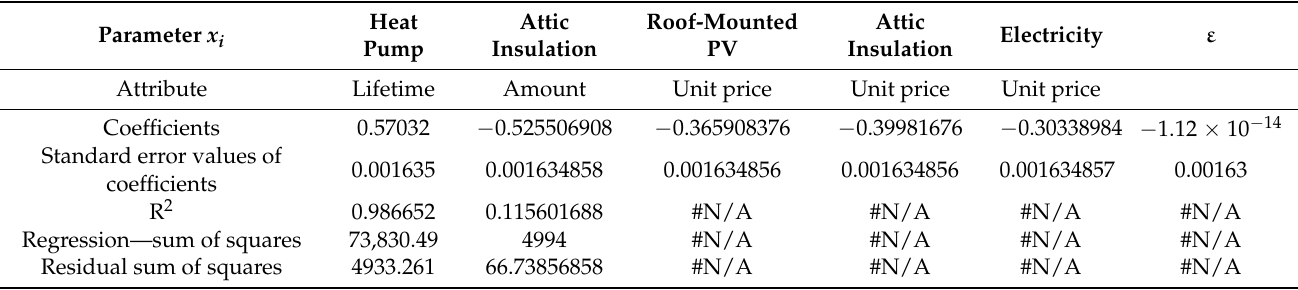
Table A3. Regression parameters for calculation model with heat